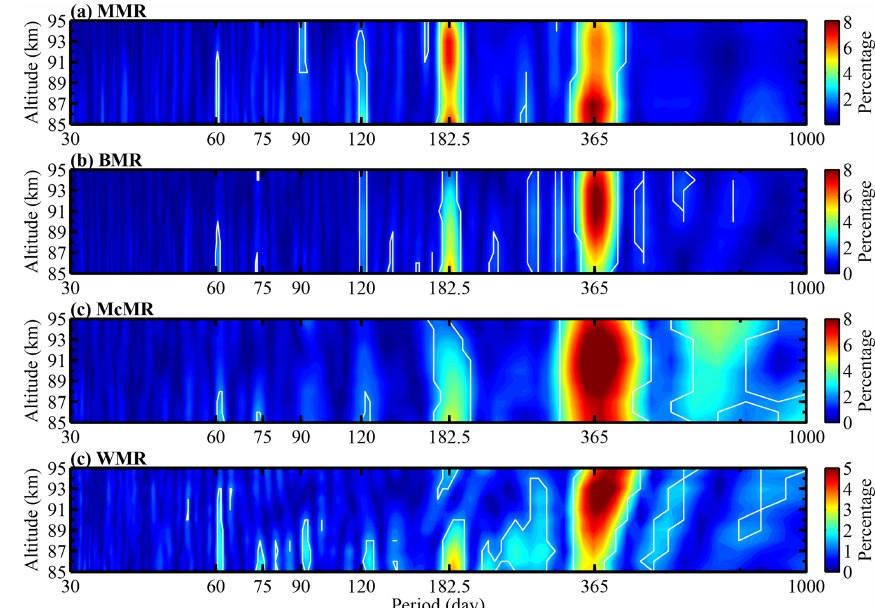
Figure 6. Same as Fig. 4 but for the MMR, BMR, McMR and WMR daily mean relative densities in the midlatitudes.